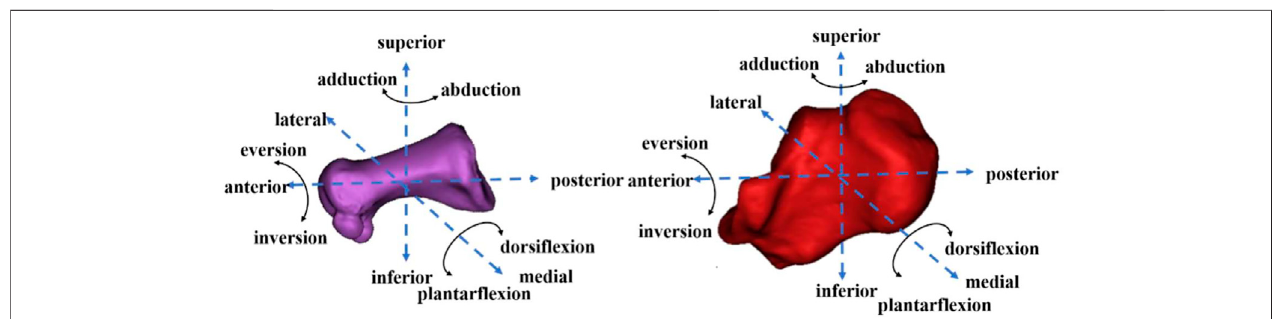
FIGURE 4 | First metatarsal (left) and calcaneus (right) motion diagram.